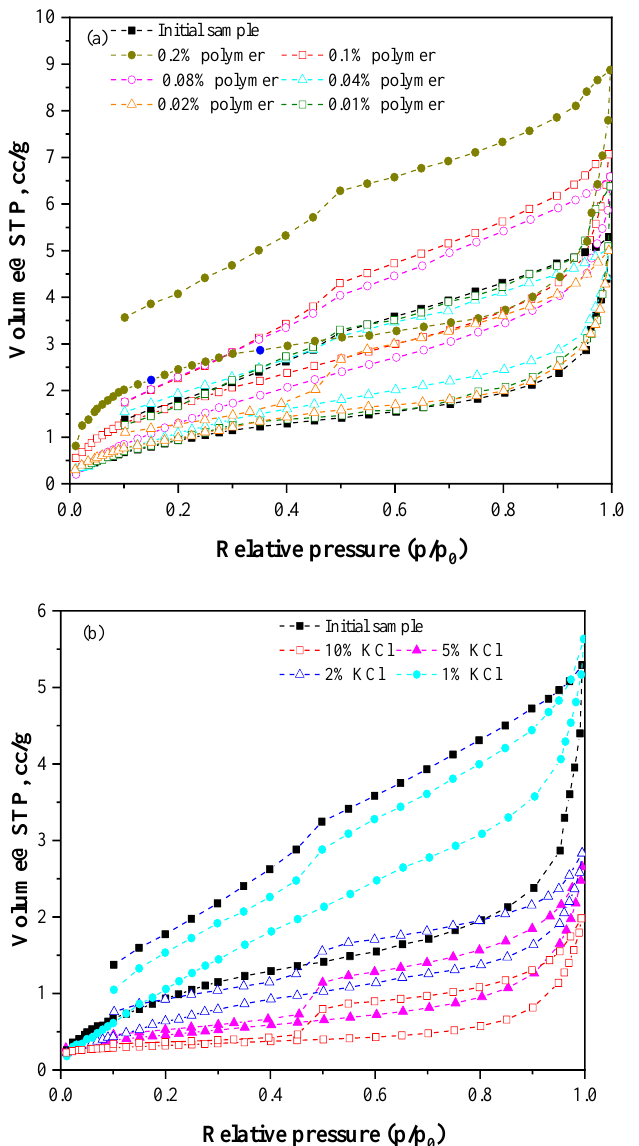
Figure 3. Low-temperature nitrogen adsorption – desorption curves of tight sandstone: ( a ) polymer and ( b ) KCl.